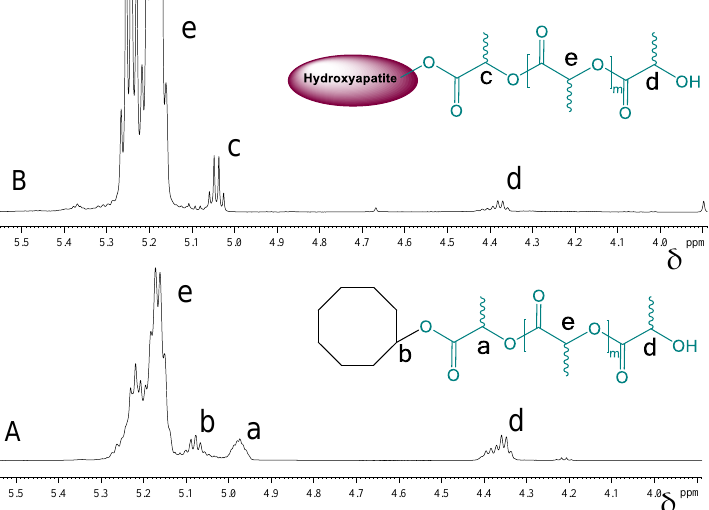
Figure 6. 1 H-NMR spectra in CDCl 3 of cyclooctanol-PDLLA ( A ) and HA-PDLLA ( B ).